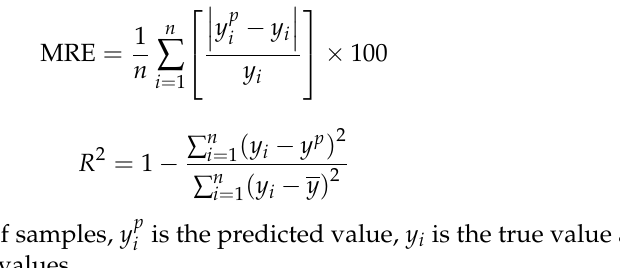
Table 3. LSTM–FNN model parameter selection.